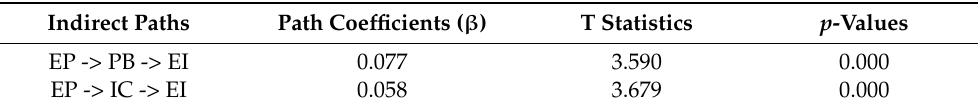
Table 4. Mediation